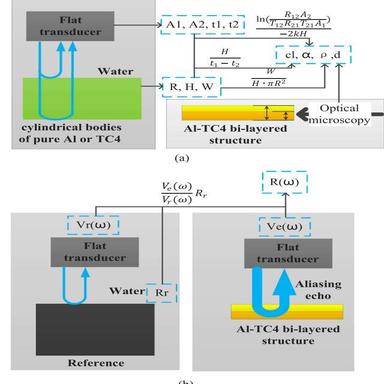
The measurement principle of (a) the real properties and (b) the experimental reflection spectrum.